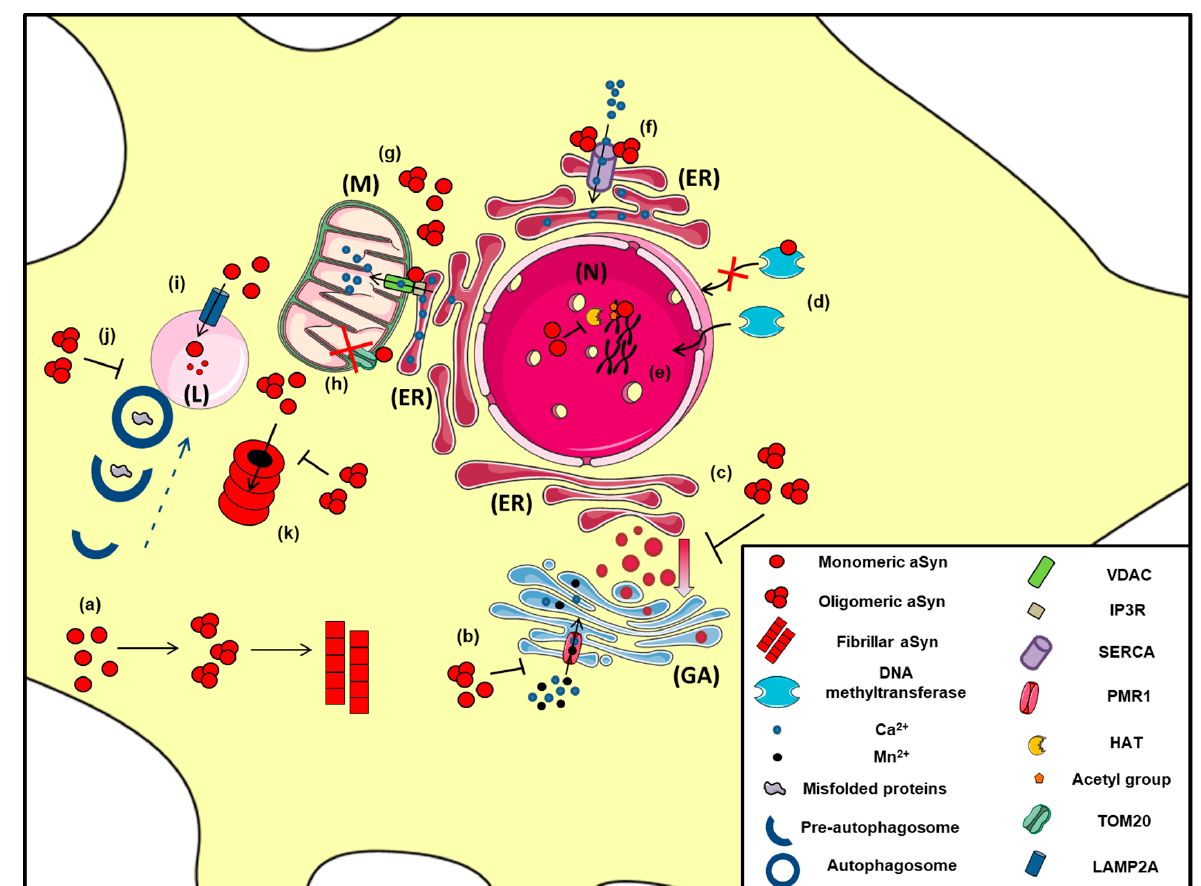
Figure 2. The proposed intracellular effects of various aSyn conformations in neurons. A schematic representation of the aberrant interactions between the various aSyn species with intracellular organelles: (a) In the cytoplasm of neurons, aSyn monomers form oligomers that can eventually become fibrils, (b) Both unfolded and aggregated aSyn impair the function of PMR1, a Ca 2+ -transporting ATPase pump that regulates Ca 2+ and Mn +2 levels in the Golgi apparatus (GA), resulting in elevated cytosolic Ca 2+ levels, (c) Both WT and mutant A53T aSyn disrupt the vesicular transport from Endoplasmic Reticulum (ER) to Golgi (GA), (d) WT aSyn inhibits the transportation of methyltransferases from the cytoplasm to the nucleus (N), thus altering DNA methylation of the SNCA gene, (e) Inside the nucleus (N), aSyn inhibits histone acetylation via its direct binding to histones or by preventing the action of histone acetyltransferase (HAT) enzymes, thus interfering in the process of gene transcription, (f) In the ER, aSyn aggregates activate the Ca 2+ -ATPase SERCA, resulting in dysregulated Ca 2+ homeostasis, (g) Both monomeric and oligomeric aSyn interact with Voltage-dependent anion channel 1 (VDAC1) and inositol triphosphate receptors (IP3Rs), the protein components involved in mitochondrial-associated ER membrane (MAM) and regulates the transmission of Ca 2+ signals from the ER to mitochondria (M), (h) aSyn binds to TOM20, a mitochondrial import receptor subunit and inhibits normal protein import, (i) Normally, monomeric or dimeric forms of aSyn are degraded in the lysosome (L) via Chaperone Mediated Autophagy (CMA), following their interaction with LAMP2A. However, under pathological conditions, impairment of CMA has been proposed to lead to aSyn accumulation and subsequent cell toxicity, (j) Oligomeric aSyn and various misfolded proteins are cleared via macroautophagy, following the fusion of autophagosomes with the lysosome. Pathological aSyn has been shown to inhibit autophagosome maturation or their fusion with lysosomes, thus impairing autophagic flux, (k) Monomeric and oligomeric aSyn are degraded via the proteasome; however, under pathological conditions, increased levels of aSyn or even soluble aSyn oligomers may inhibit proteasomal function, leading to aSyn accumulation and the formation of insoluble